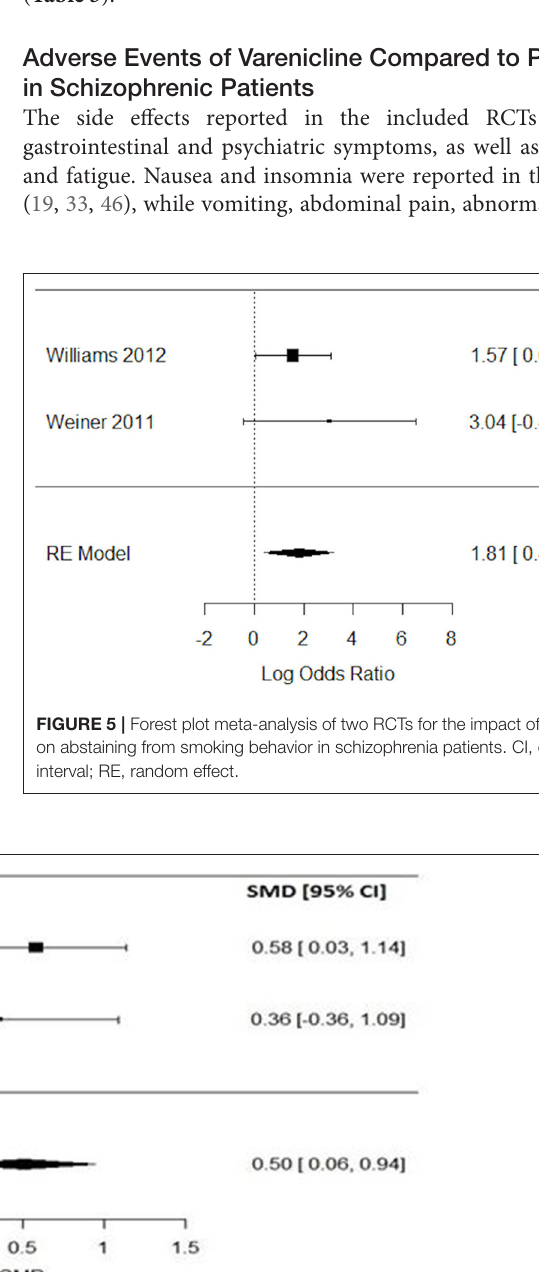
Frontiers in Psychiatry |